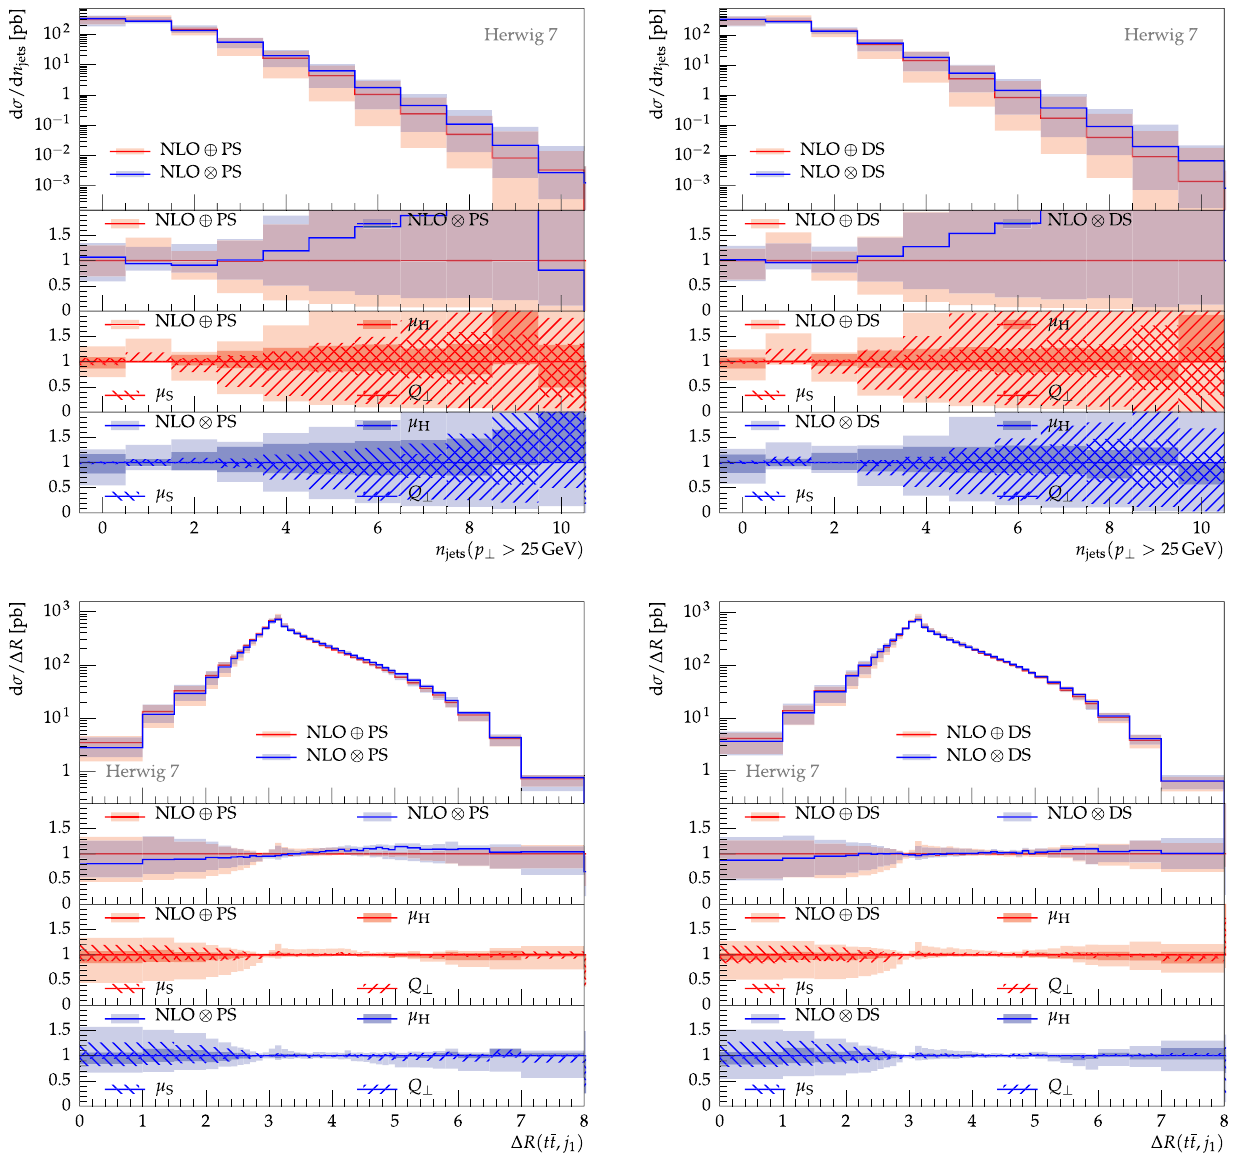
Fig. 8 Same as Fig. 7, in this case showing the inclusive jet multiplicities and the R distance between the t ¯ t -pair pair and the hardest jet. See the text for